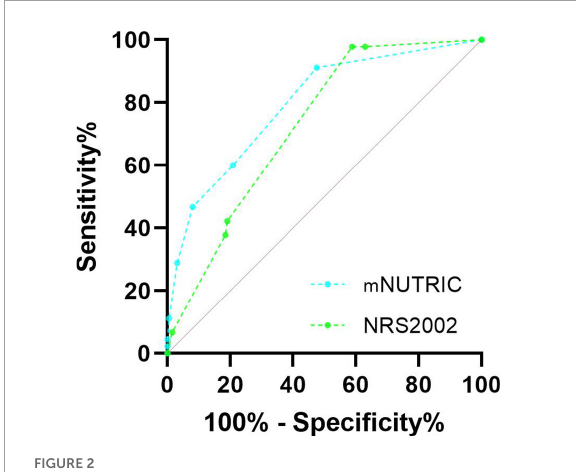
FIGURE2 Receiver operating characteristic curves of NRS2002 and mNUTRIC to predict 28-day mortality in severely burned patients. The AUC for the NRS2002 was 0.726 (95% CI = 0.662–0.789), the AUC for the mNUTRIC was 0.795 (95% CI = 0.726–0.864). ROC, receiver operating characteristic; AUC, area under ROC curve; NRS2002, Nutrition Risk Screening 2002; mNUTRIC, the modified Nutrition Risk in Critically ill.